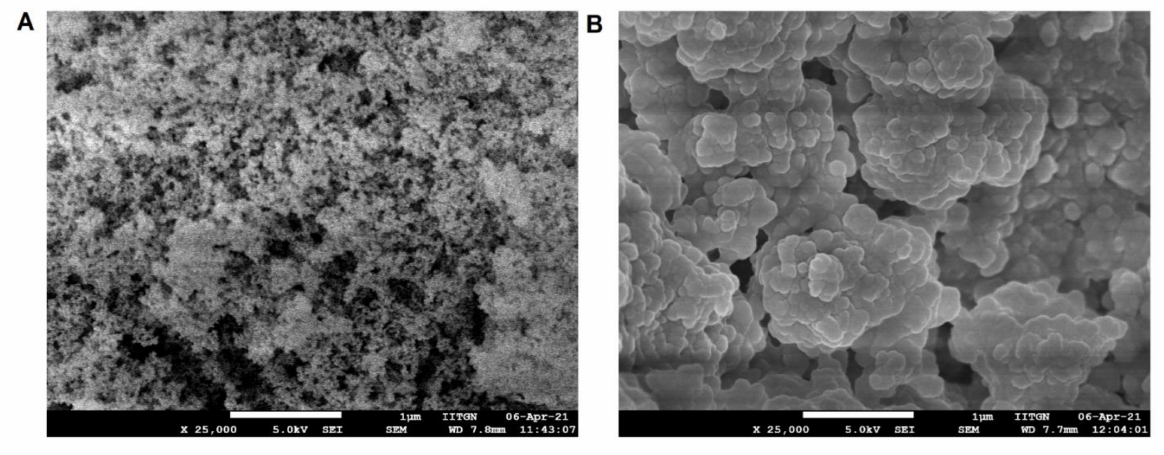
Figure 13. Representative scanning electron microscopy photographs of ( A ) Aerosil 200; and ( B ) prepared solid self-nanoemulsifying drug delivery system (S-SNEDDS). Scale bar represents 1 µ